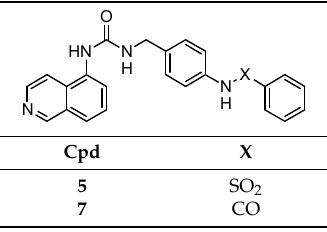
Table 3. Amide and sulfonamide derivatives of isoquinolinyl urea 5 and 7 .